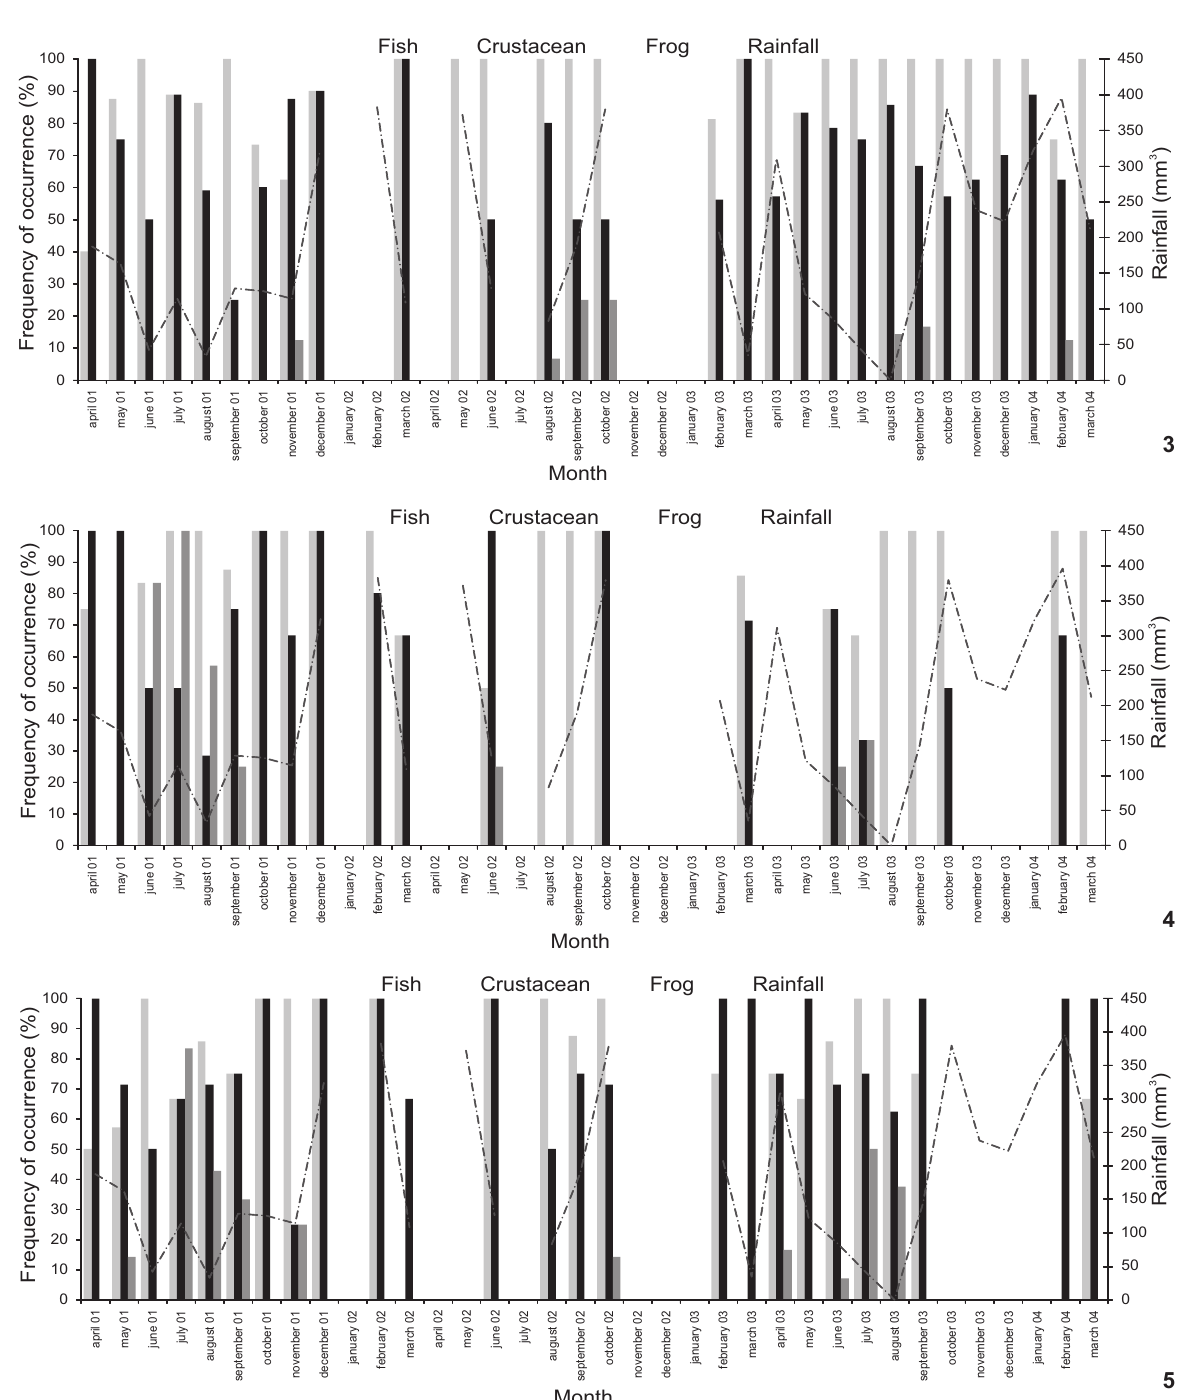
Figures 3-5. Frequency of Occurrence of fish, crustaceans and frogs in the Neotropical otter spraints collected in different stretches, including rainfall data for the Mambucaba catchment during the present study. Each letter is related to one stretch, as follows: (3) Stretch I, (4) Stretch II, and (5) Stretch III. Dashed lines represent the rainfall data per month in the study area during the study period (rainfall data obtained from the Meteorology System of Centro Nuclear Almirante Álvaro Alberto – ZOOLOGIA 28 (1): 37–44, February, 2011